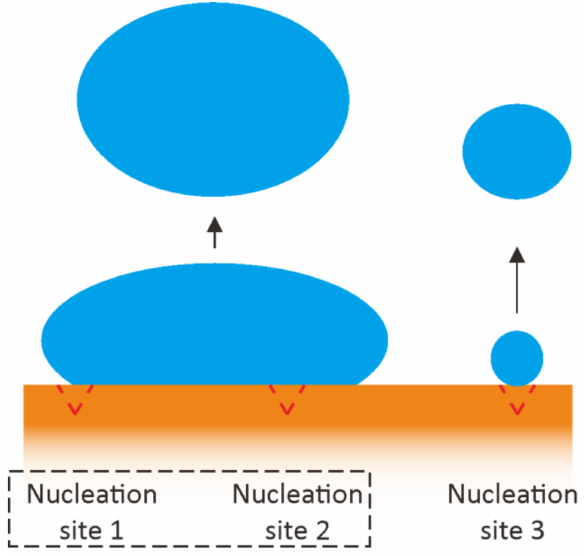
Figure 12. Illustration of bubble growth and departure from the merged bubble